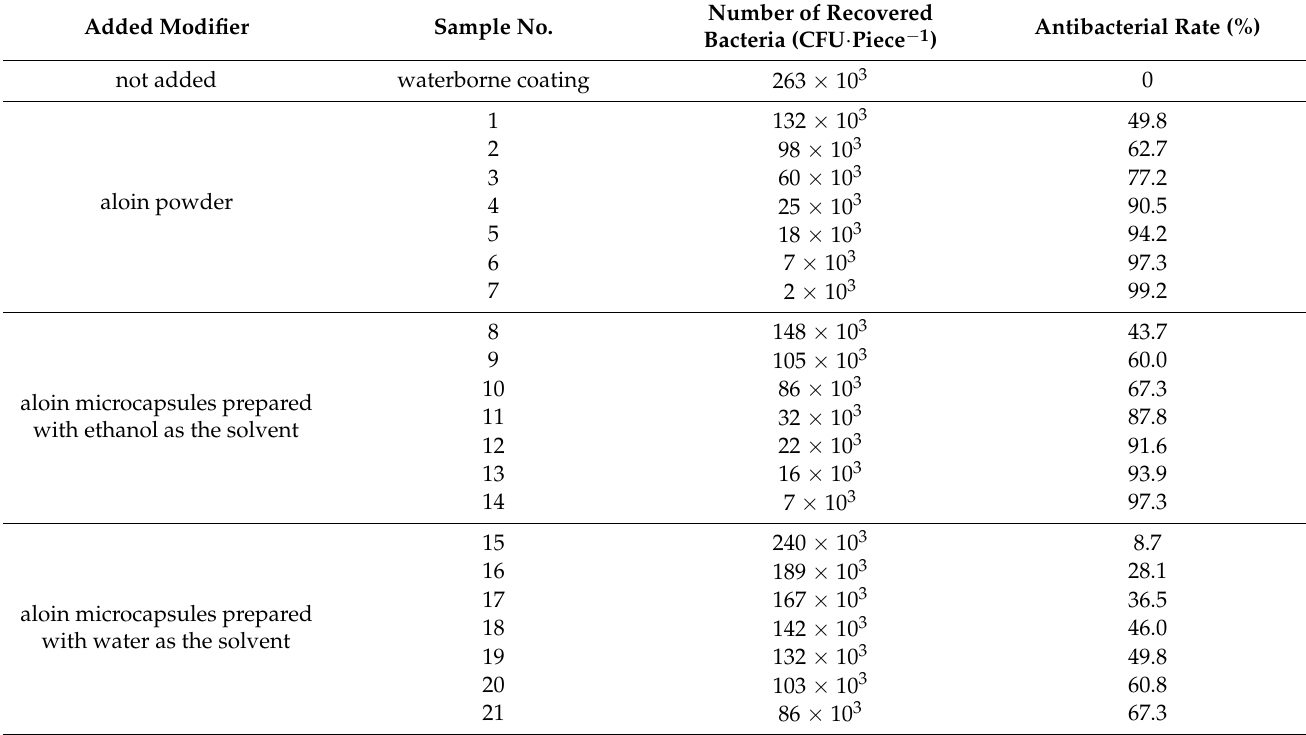
Table 3. Actual recovery of viable bacteria and antibacterial rate of each